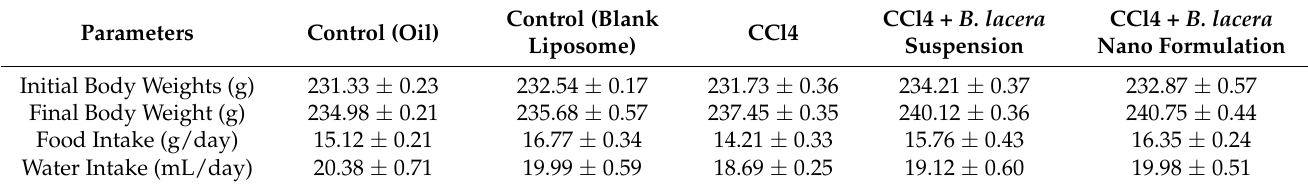
Figure 5. Effect of B. lacera leaf extract and its liposomal preparation on water intake of CCl 4 -treated rats for14 days. Data are presented as mean ± standard error of mean, where n = 6.